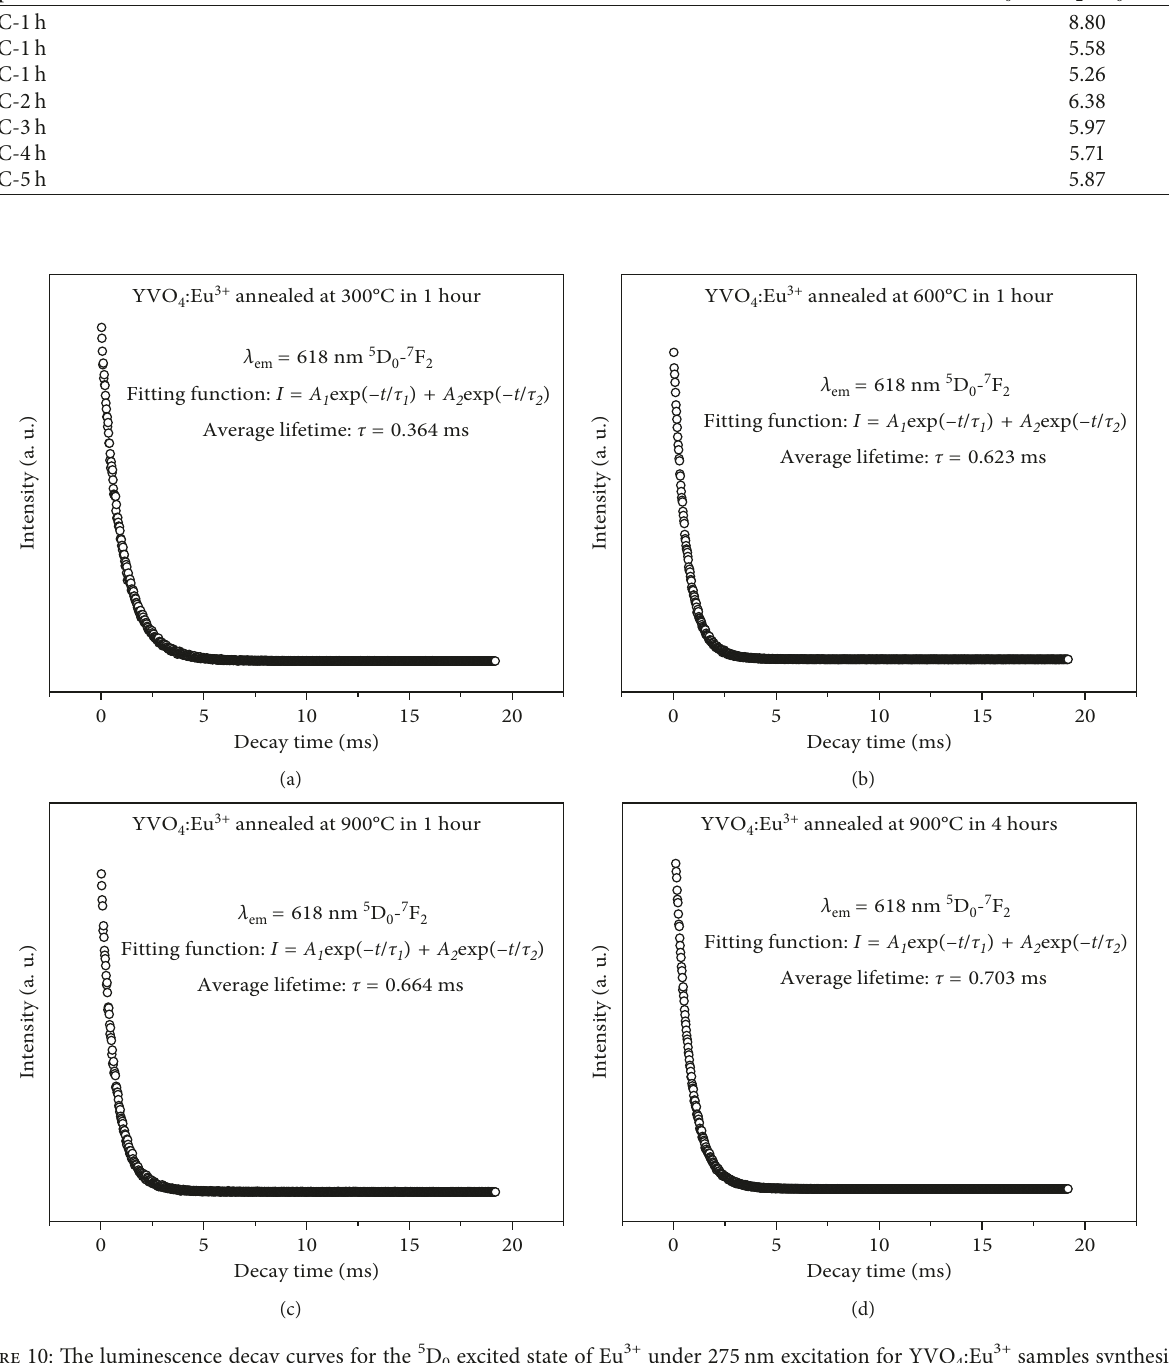
Figure 10: The luminescence decay curves for the 5 D with different annealing temperatures and